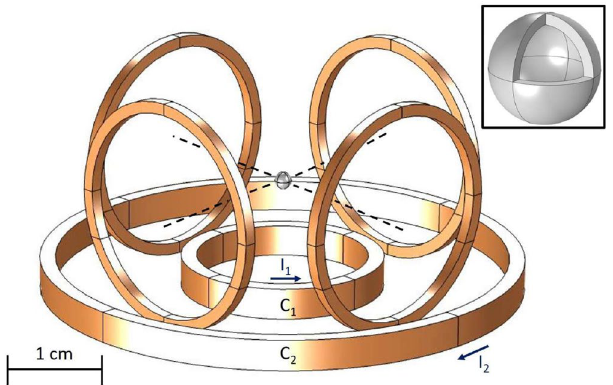
Figure 1. Experimental arrangement. The bottom coils ( C 1 , C 2 ) are fed with opposite currents. The lateral coils are placed in a symmetrical perpendicular configuration. The sphere is shown at the crossing of the axes of the lateral coils . The inset contains a detailed view of the hollow indium